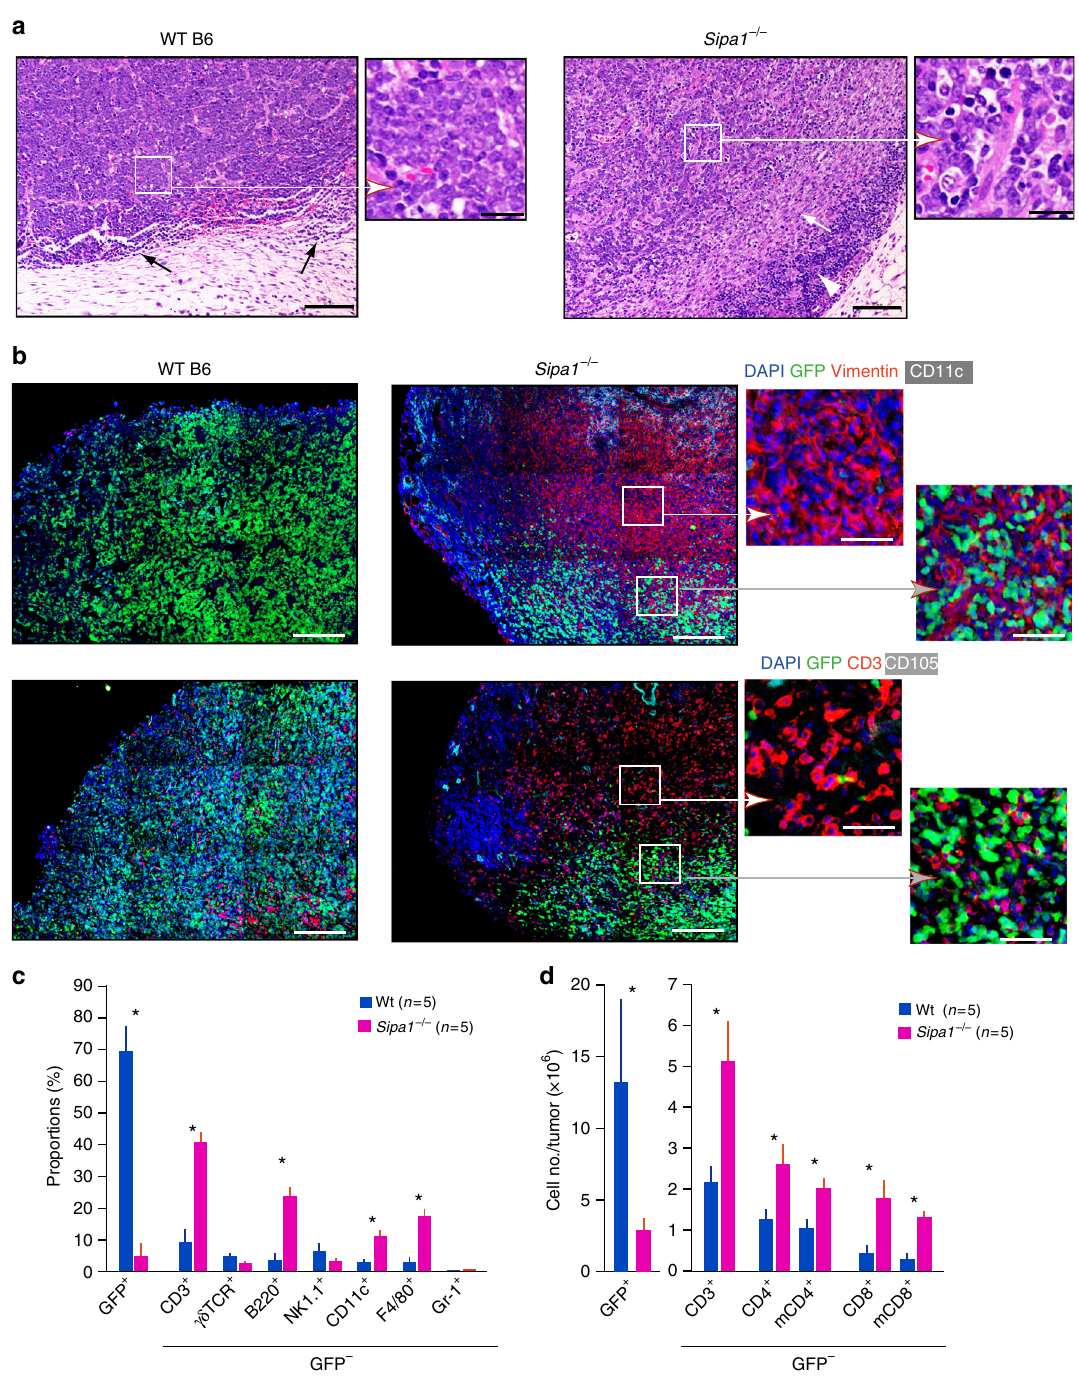
Fig. 6 Marked increase in memory T-cell in fi ltration inside Bcr-Abl + tumors coinciding with increase vimentin high MSCs in Sipa1 − / − mice. a Bcr-Abl + HPCs were subcutaneously injected in Matrigel matrix in Wt and Sipa1 − / − mice, and the tumors on day 15 were fi xed and stained with hematoxylin and eosin. Black arrows for Wt mice indicate mononuclear cell in fi ltration in the peripheral edges of the tumor mass. Scale bars, 100 and 20 μ m (enlarged). The white arrow and arrowhead indicate stromal reaction and dense mononuclear cell in fi ltration, respectively. Enlarged images of boxed regions are also shown. b Serial sections of subcutaneous Bcr-Abl + tumors in Wt and Sipa1 − / − mice were immunostained with indicated antibodies. Enlarged images of boxed regions are also shown. Scale bars, 200 and 50 μ m (enlarged). c Subcutaneous Bcr-Abl + tumors on day 15 in Wt and Sipa1 − / − mice were dispersed into single-cell suspensions in collagenase/DNase I solution and analyzed for the indicated cell markers with FACS. The means and SEs of the proportions of fi ve mice per group are shown. * p < 0.01 (two-tailed unpaired Student ’ s t -test). Experiments were done three times with similar results. d Subcutaneous Bcr-Abl + tumors on day 12 in Wt and Sipa1 − / − mice were FACS analyzed, and the actual cell numbers of indicated cell types in tumor tissues were calculated. The means and SEs of fi ve mice per group are shown. m memory phenotype; * p < 0.01 (two-tailed unpaired Student ’ s t -test). Experiments were done twice with similar